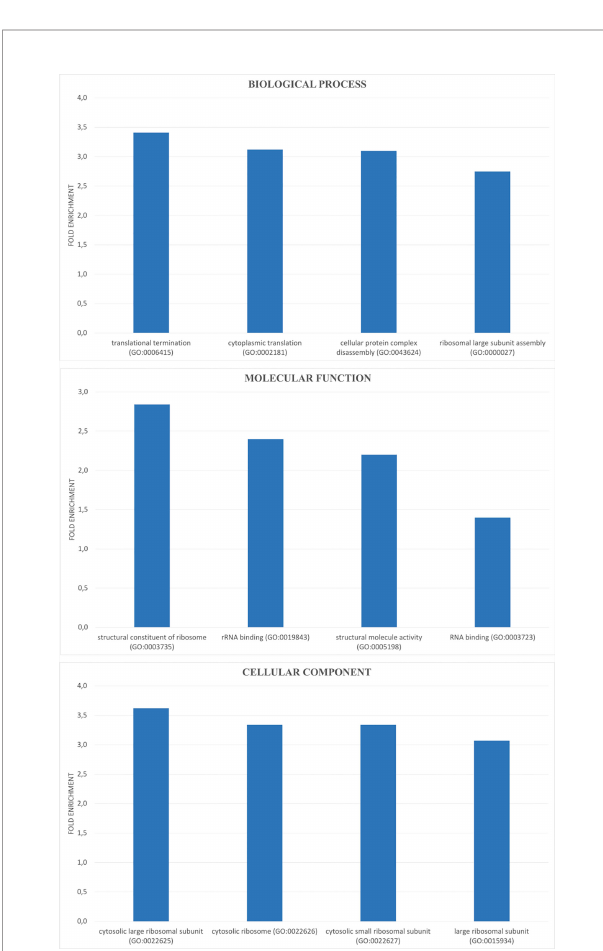
FIGURE 2 | GO enrichment analysis of DEGs. DEGs were analyzed for enrichment in three GO ontologies (biological process, cellular component, and molecular function) and the top 4 over-represented for each category are shown as blue bar with the corresponding GO